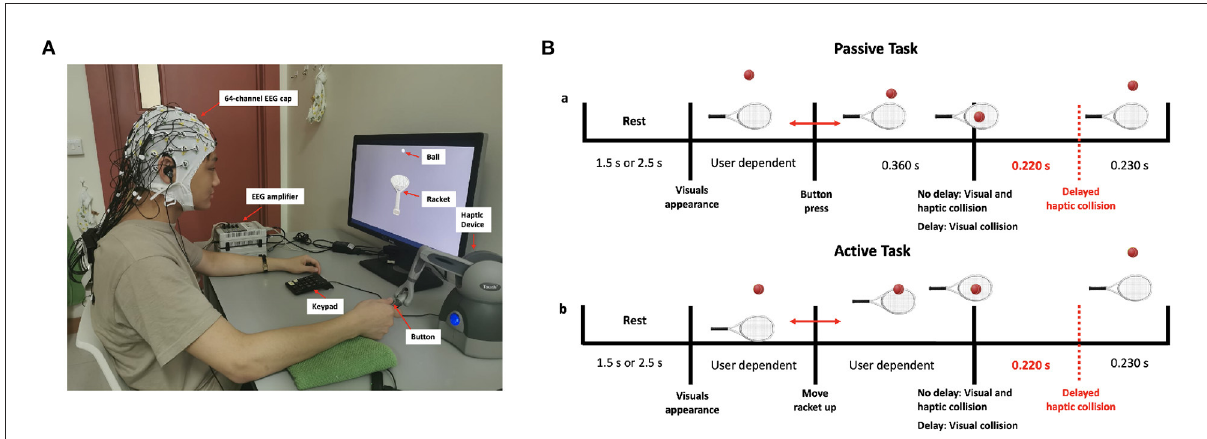
FIGURE1 (A) Experimental setup showing a participant correctly holding the stylus of the haptic device (B) Timeline of the passive and active